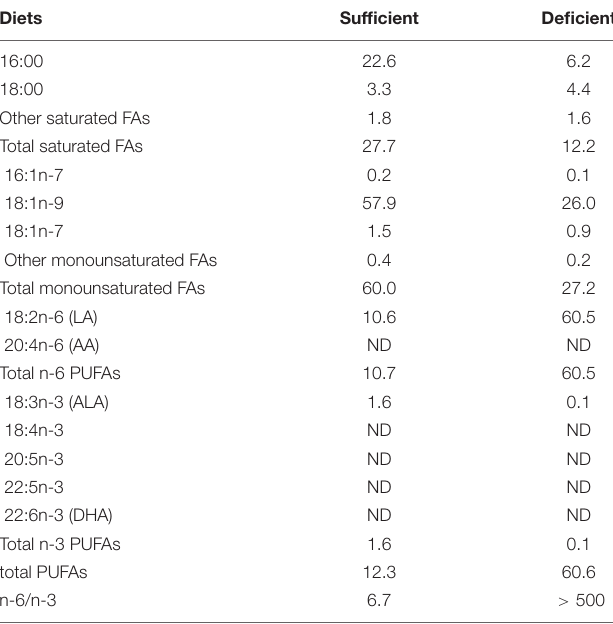
TABLE 1 | Fatty acid composition of the dietary lipids (% by weight of total fatty